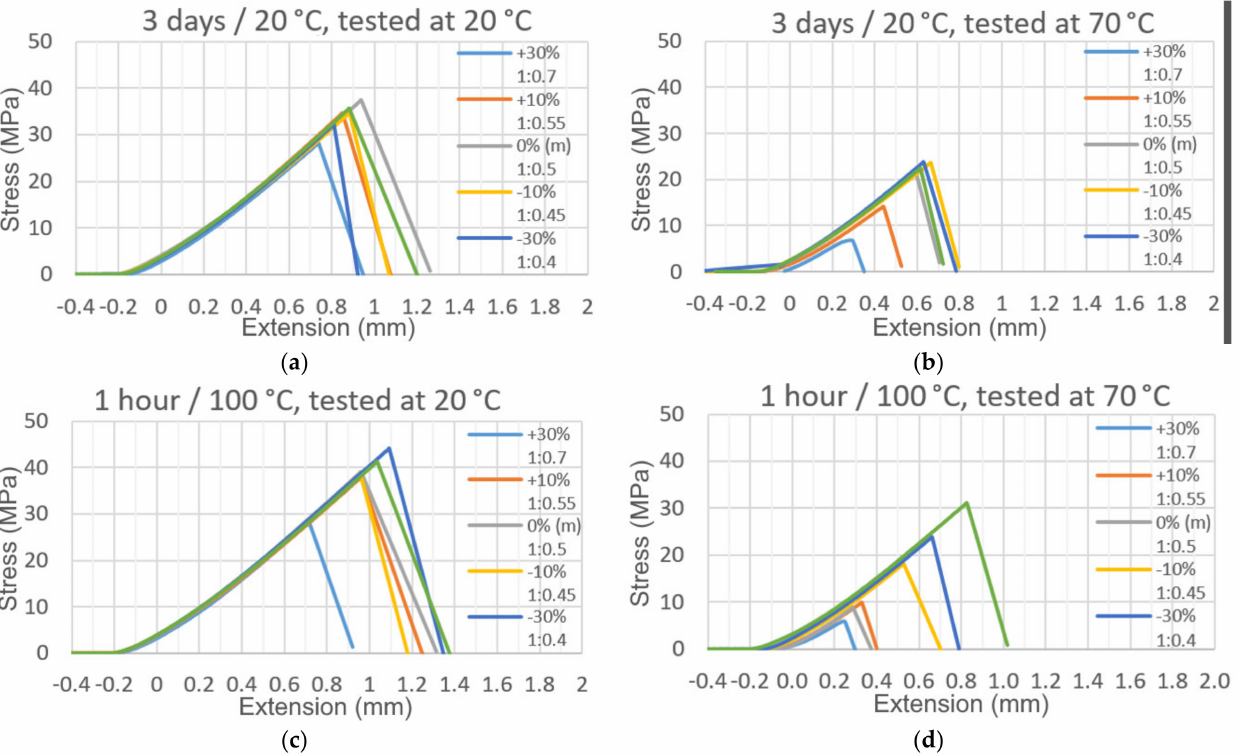
Figure 10. Stress–extension graphs of tested adhesive joints prepared under inaccurate addition of hardener component in adhesive (random samples): ( a ) cured 3 days at 20 ◦ C, tested at 20 ◦ C; ( b ) cured 1 h at 100 ◦ C, tested at 20 ◦ C; ( c ) cured 3 days at 20 ◦ C, tested at 70 ◦ C; and ( d ) cured 1 h at 100 ◦ C, tested at 70 ◦ C.